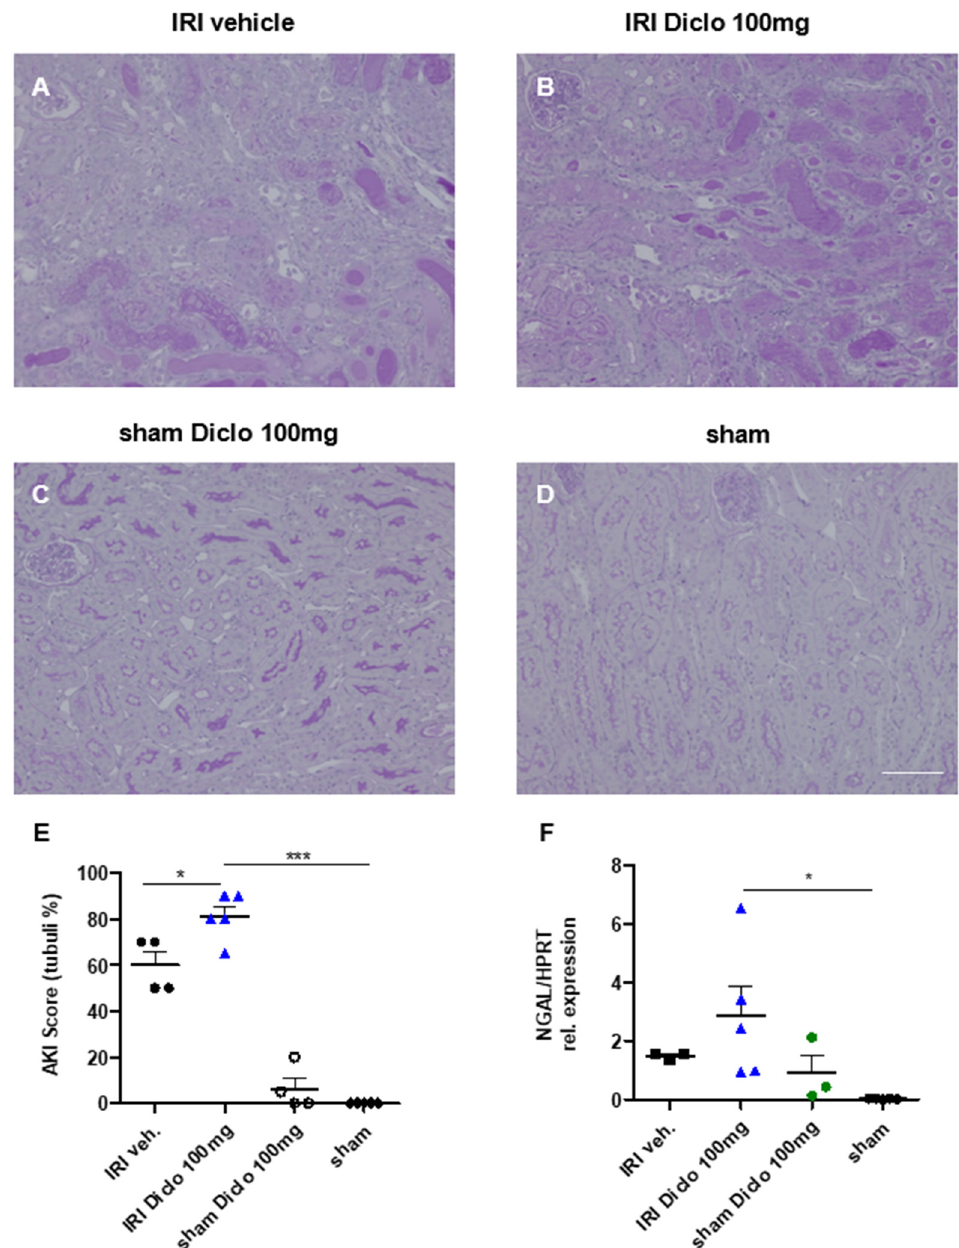
Figure 3. Renal morphology three days after renal ischemia–reperfusion injury (IRI) and repetitive diclofenac treatment. PAS-stained kidney sections of IRI m treated with vehicle ( A ), or repetitive doses of 100 mg diclofenac over three days ( B ) are shown and acute tubular injury (ATI) as a morphological sign of AKI was assessed in the outer medulla. Sham-operated m treated with 100 mg of diclofenac over three days ( C ) and vehicle-treated sham m ( D ) served as control. Quantification of ATI is shown in E. Repetitive doses of diclofenac significantly aggravated morphological renal damage compared with vehicle treatment after IRI. Diclofenac treatment in the setting of sham surgery did not cause significant renal damage ( E ). Renal tissue NGAL expression increased after IRI and repetitive diclofenac doses indicating tubular injury ( F ). n = 3–5 m in each group are shown. * p < 0.05, *** p < 0.001. Scale bar 100 µ